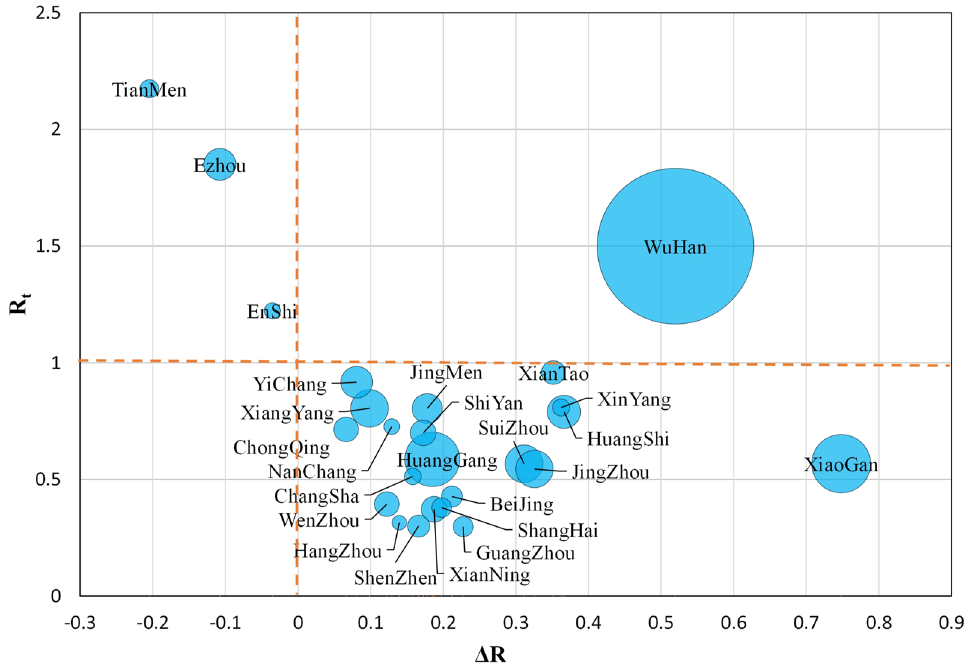
Figure 5. The relationship between the R value on February 10, 2020 (R t ) and the average decline in R in the past five days (ΔR), where the size of the circle represents the number of confirmed cases in each city.